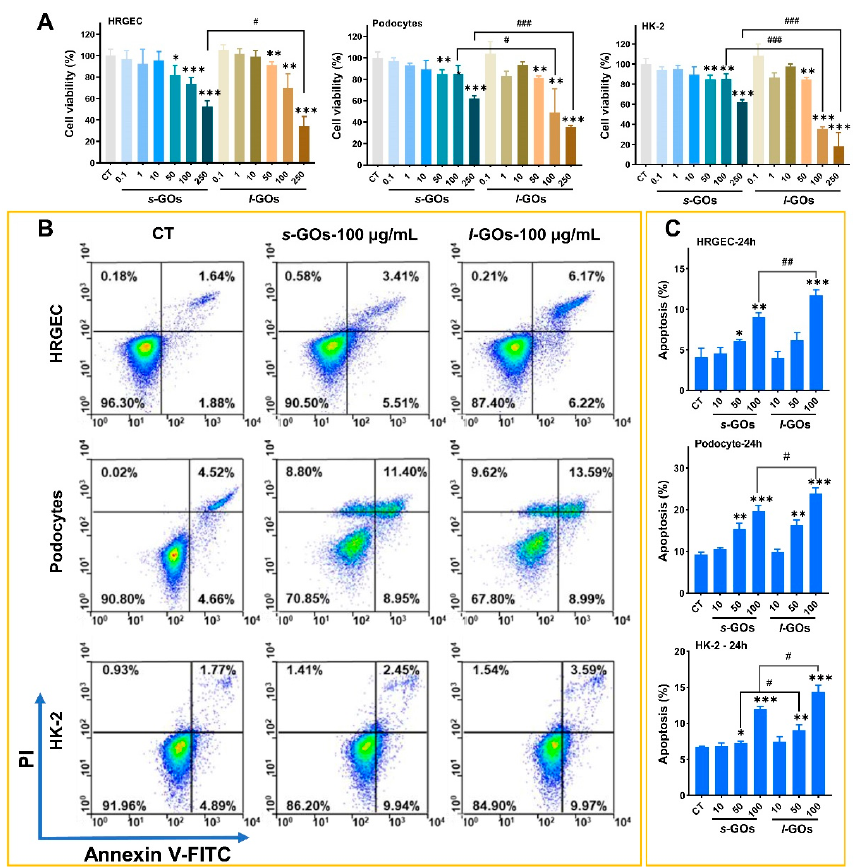
Figure 4. Cytotoxic assays of s -GO and l -GO treatments on HRGECs, human podocytes, and HK-2 cells. ( A ) Cell viability assays of HRGECs, podocytes, and HK-2 cells following s -GO and l -GO treatments at 0.1, 1, 10, 50, 100, and 250 µ g/mL doses for 24 h. ( B ) Annexin V-FITC/PI flow cytometry for detection of apoptosis in cells treated with 100 µ g/mL s -GOs and l -GOs for 24 h. ( C ) Percentage of apoptotic HRGECs, podocytes, and HK-2 cells. * p < 0.05, ** p < 0.01, and *** p < 0.001 for GO-treated vs. the control group; # p < 0.05, ## p < 0.01, and ### p < 0.001 for s-GO − vs. l -GO − treated